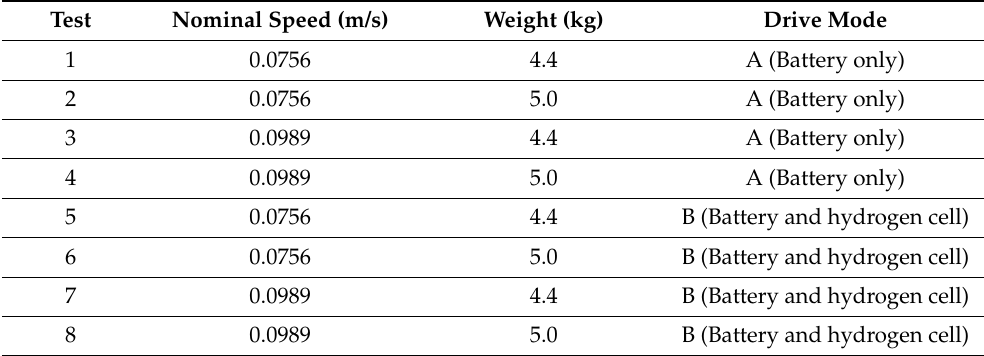
Table 2. Configuration for each test divided by the drive modes. By: